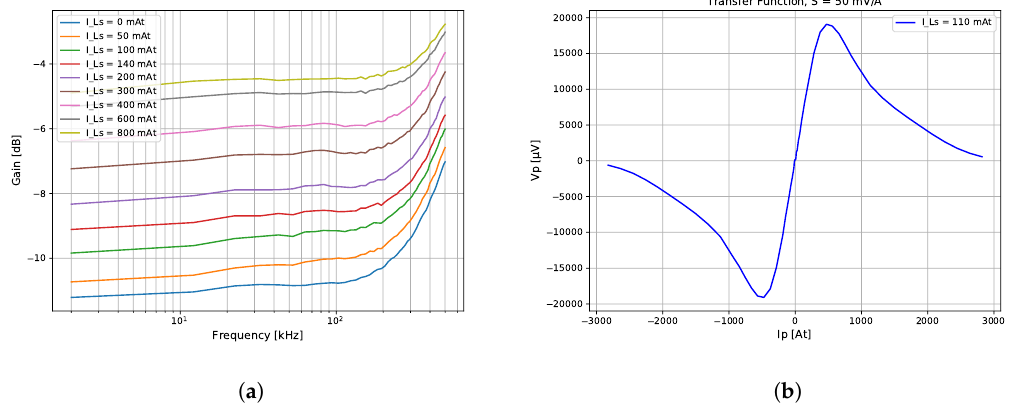
Figure 9. Platiše Flux Sensor characteristics of the 40A9R. ( a ) CCVR characteristics; ( b ) Sensor transfer